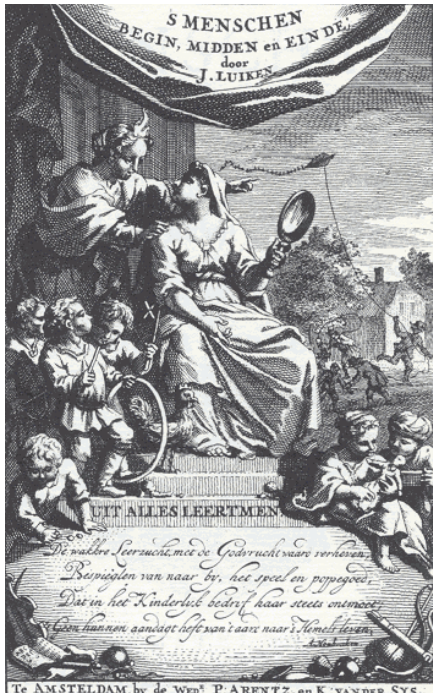
Figure 1. Jan Luyken, Frontispiece, Des Menschen Begin, Midden en Einde , Amsterdam: K.van der Sys. 1712, Engraving.